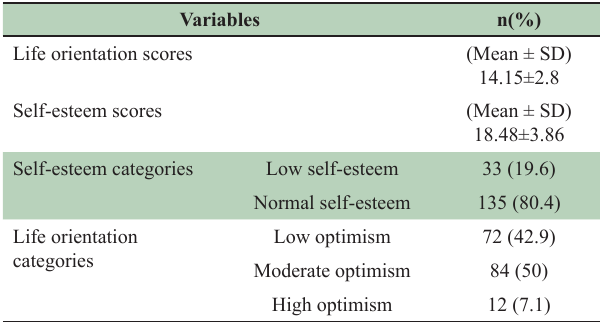
Table-II: Self-esteem and life orientation (optimism) among the participants.